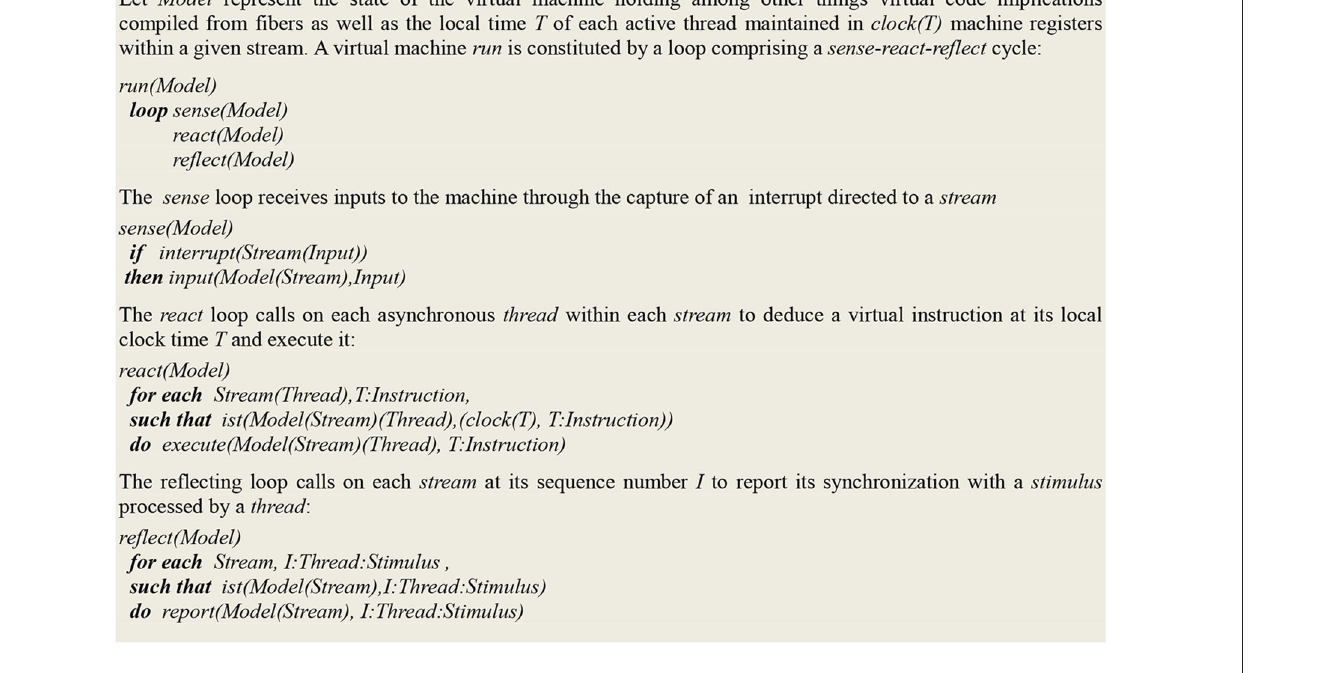
FIGURE 1 | High level definition of a virtual machine